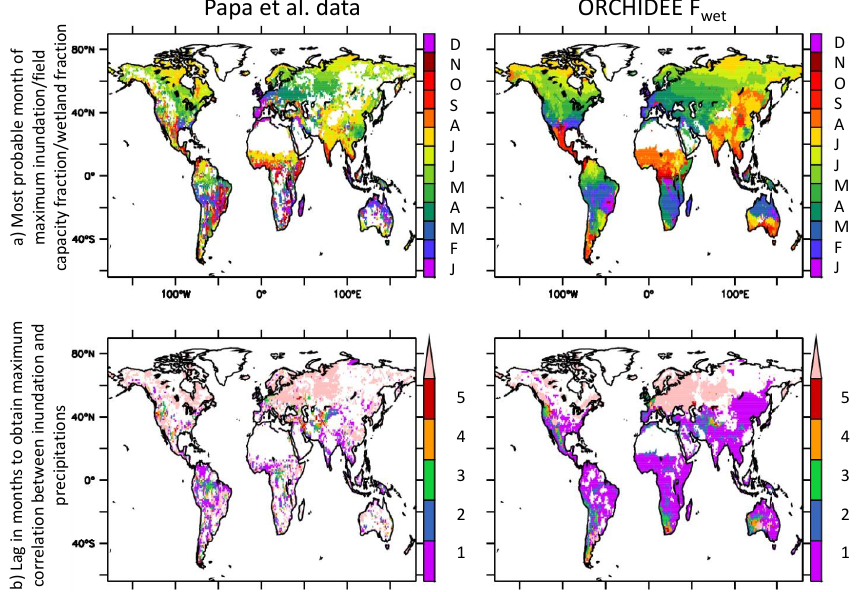
Fig. 6. Spatial distribution of the most probable month of maximum inundation / saturation (a) and relationship between the time variation of inundation / saturation and one of precipitation (b) . Grid-cells whose seasonal amplitude is too weak are masked for (a) . (b) displays the lag in month to obtain the maximum correlation between inundation/precipitation and the